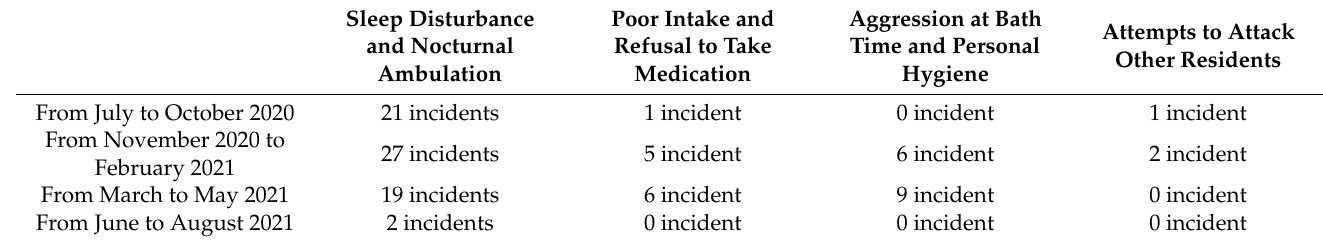
Table 3. Incidents from July 2020 to August